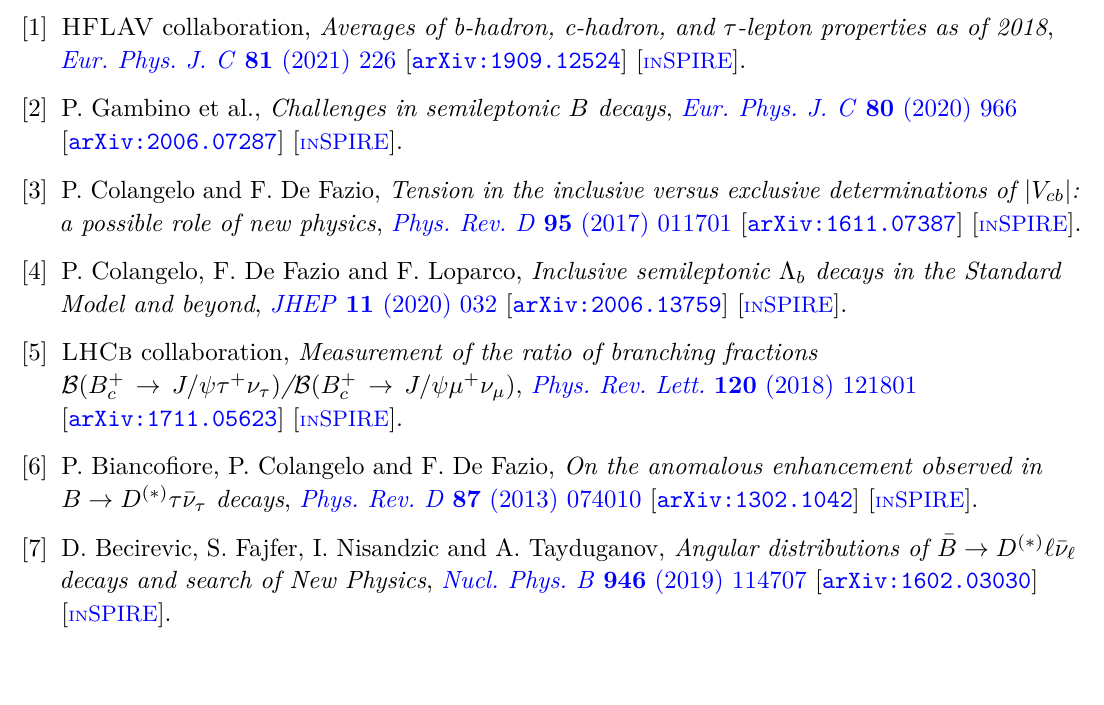
table 1. The values of a Open